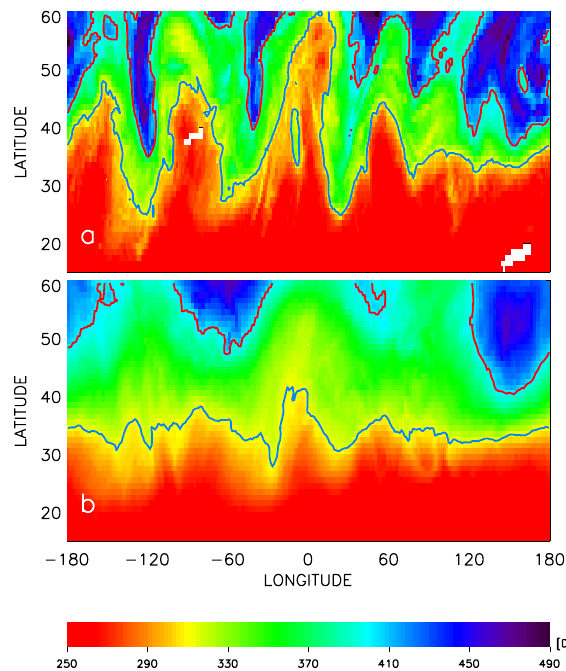
Fig. 1. (a) Total ozone image for 11 March 1990, from the TOMS instrument on the Nimbus-7 satellite. (b) Monthly average for March 1990, averaged at the pixel level. The solid blue line shows the location of the sub-tropical front, while the solid red line shows the location of the Polar front The units of the color bar are Dobson Units (1 DU=1 millimeteratmospheres − 1 )